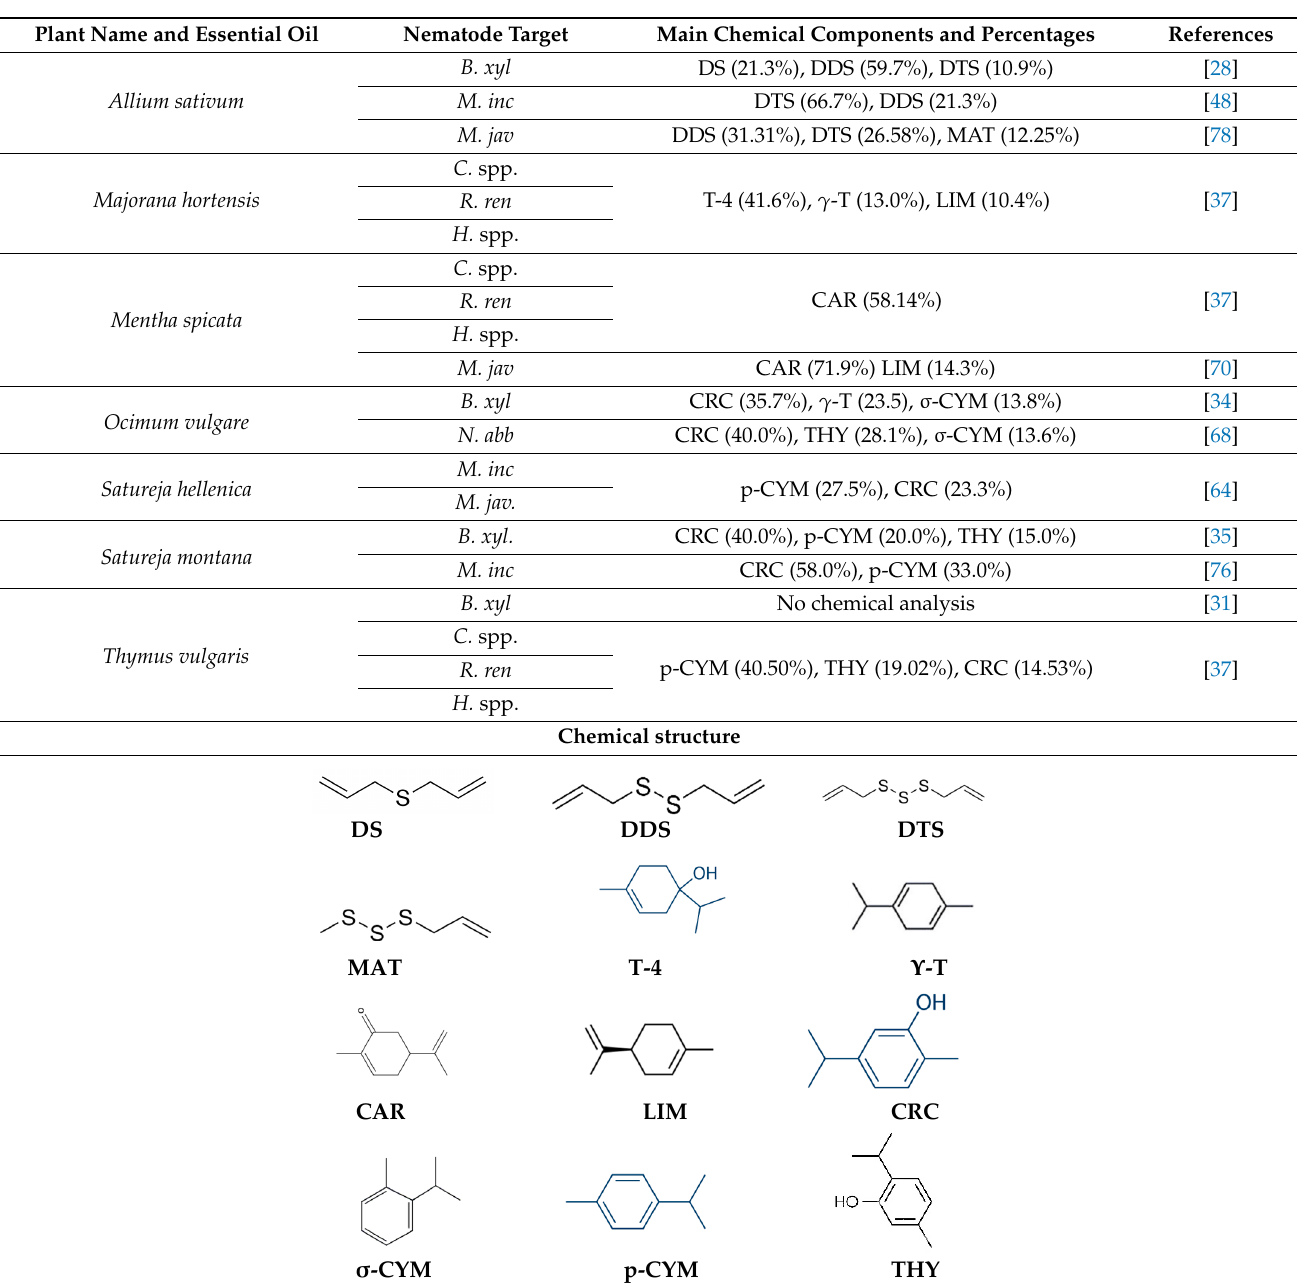
Table 4. Names of plant species from which essential oils (EOs) were extracted and used on nematodes. Percentages of main chemical components (considered with a percentage >10%) derived from chemical analysis, and related chemical structure configuration, when required by the study.